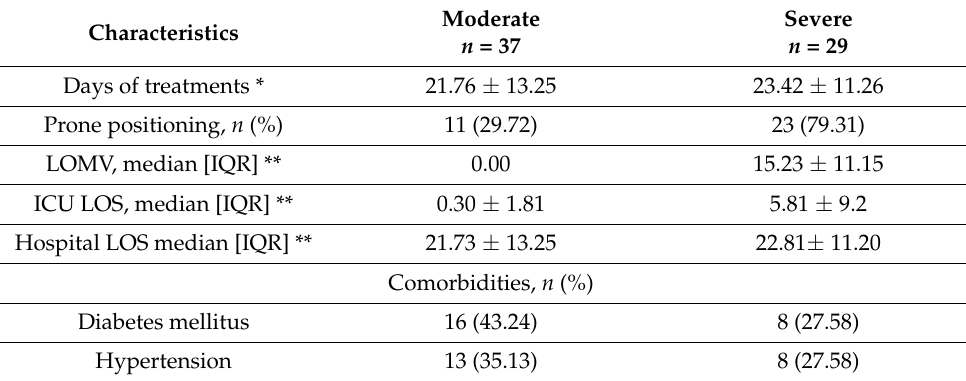
Table 2. Pharmacological treatment of patients with COVID-19